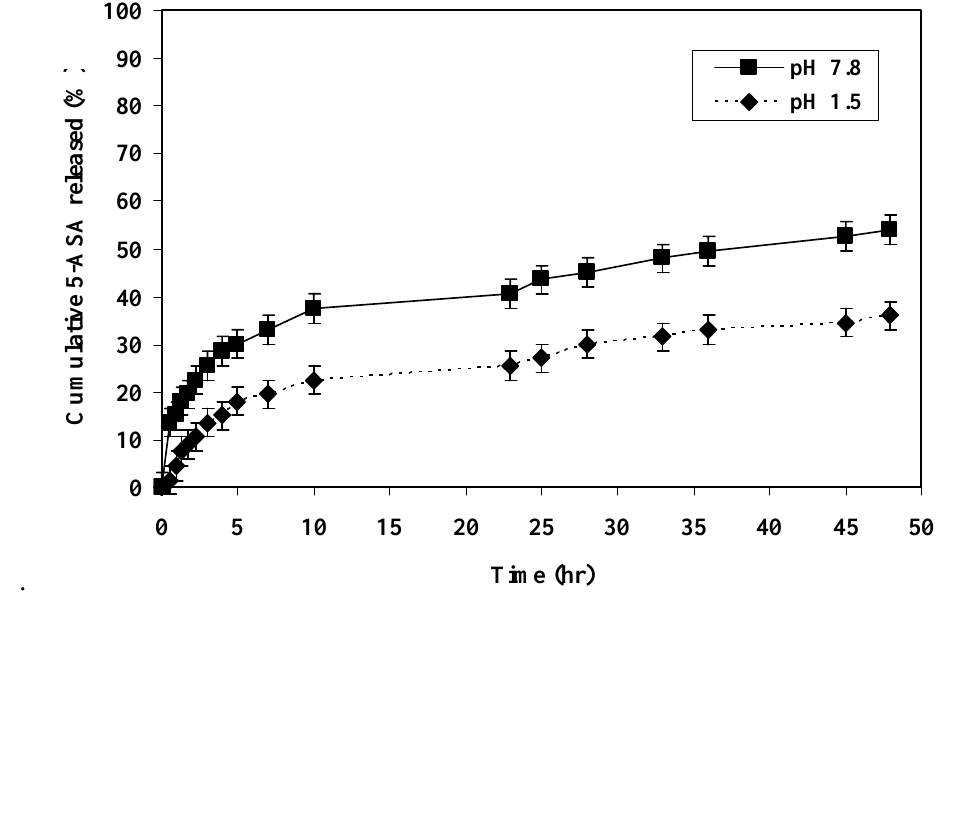
Figure 2. In vitro 5-ASA release from polymer V in phosphate buffer solutions (pH 7.8 and 1.5) at 37